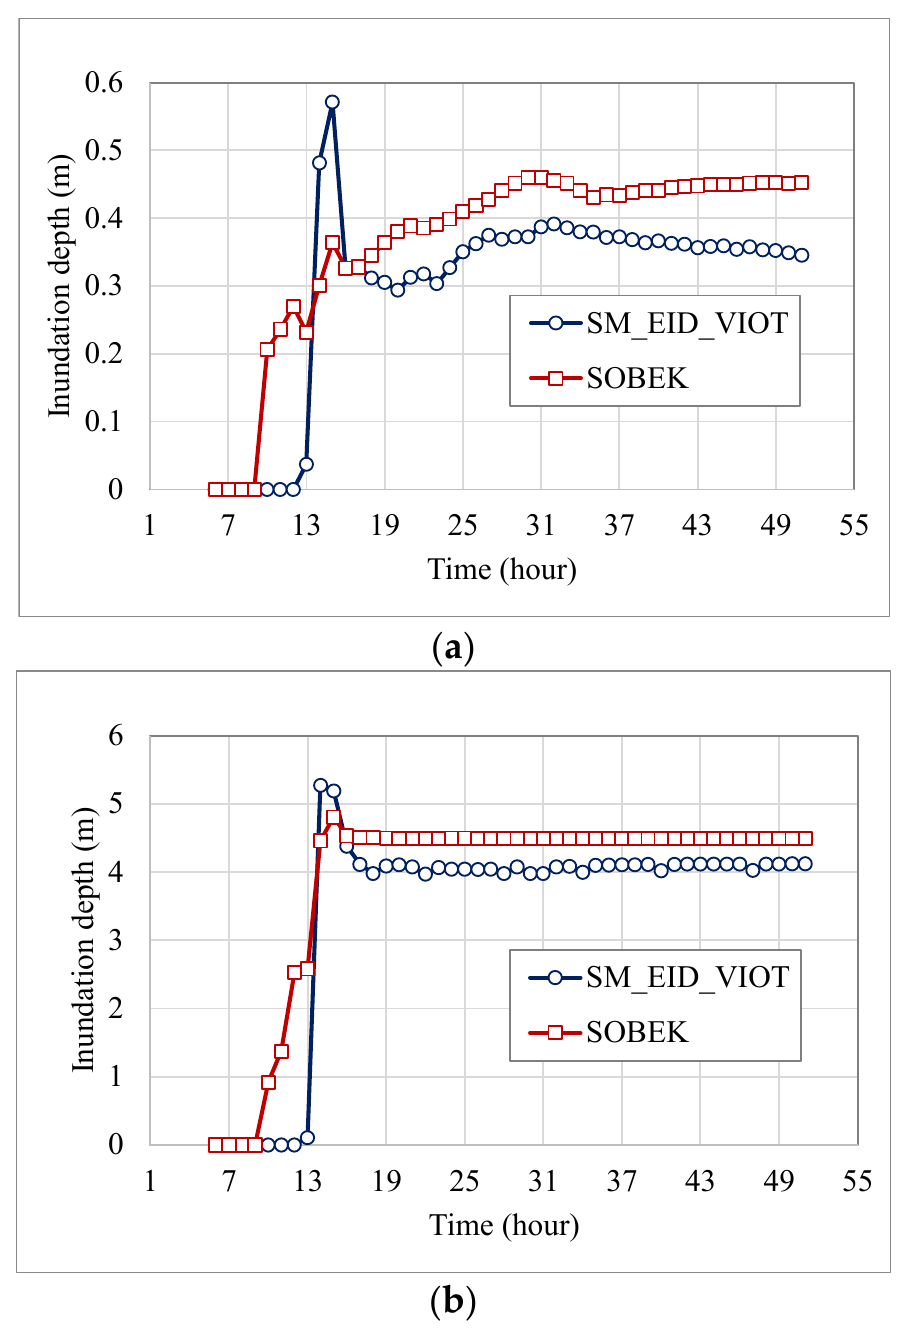
Figure 19. Comparison of the average and maximum of the inundation depths at the VIOT grids by the proposed SM_EID_VIOT model with the validated data. ( a ) Average inundation depth. ( b ) Maximum inundation depth.